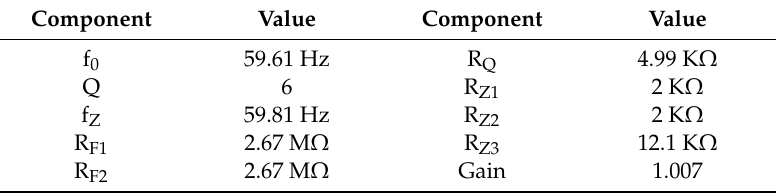
Figure 2. Notch Filter with the UAF42. Table 1. Values obtained for the Notch filter with the Filter 42 program.